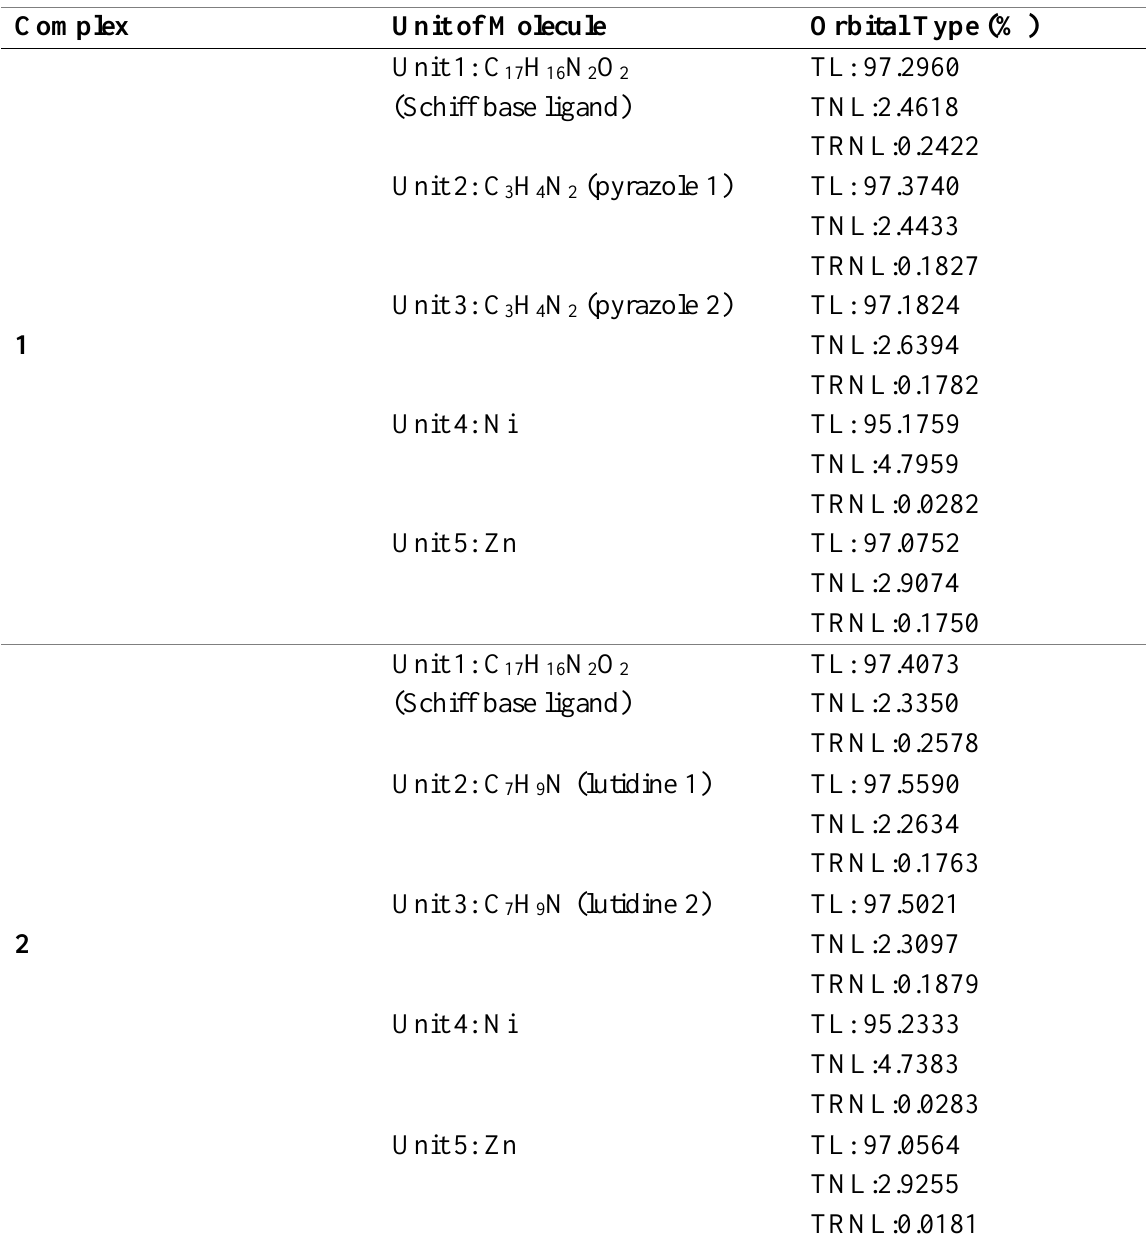
Table S2. Second-order perturbation analysis results of the atom orbitals obtained from the NBO